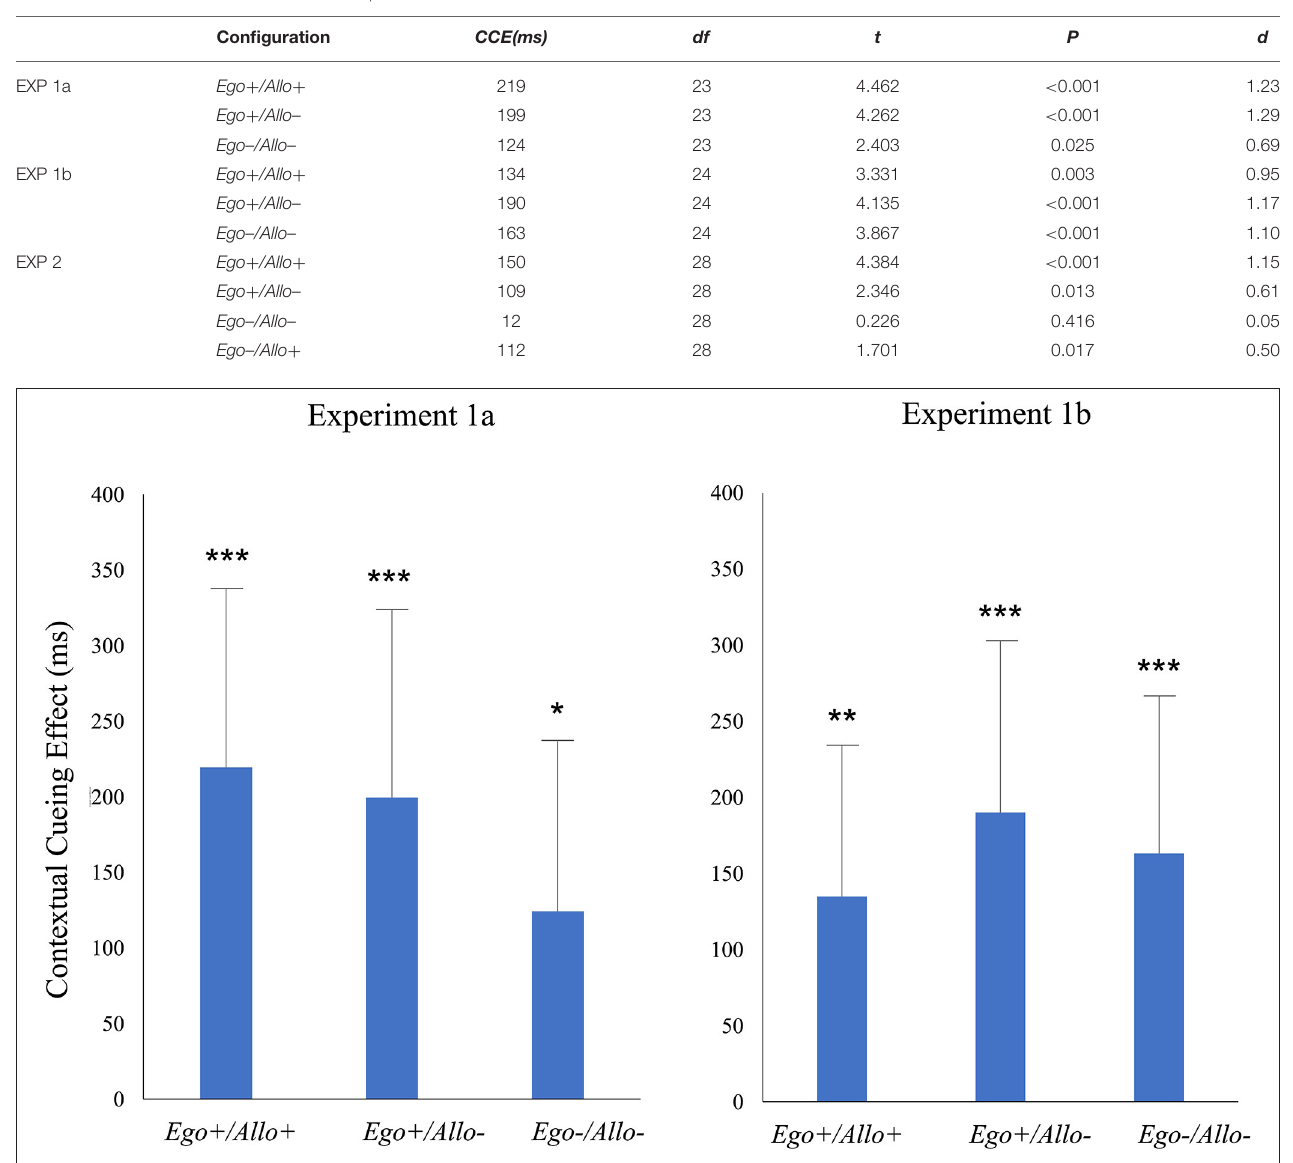
FIGURE 2 | Contextual cueing in the test phase of Experiment 1a and Experiment 1b for three repeated configurations ( Ego + /Allo + ; Ego + /Allo–; Ego–/Allo– ). Significant differences revealed by pairwise comparisons of RT New -RT Repeated vs. zero are indicated by asterisks. Error bars represent ± 1SE of the mean. The statistical results are listed in Table 1